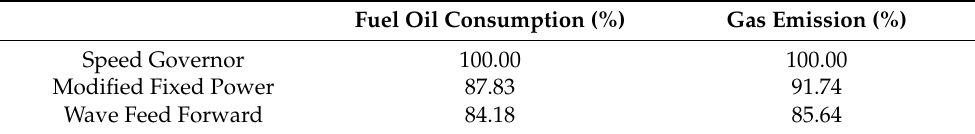
Table 10. The Atlantic case—accumulated FOC and gas emission